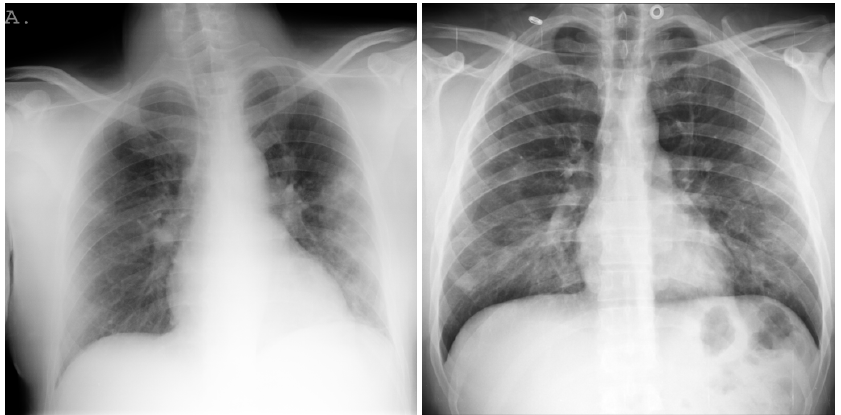
Figure 7. Examples of BIMCV COVID19+ images